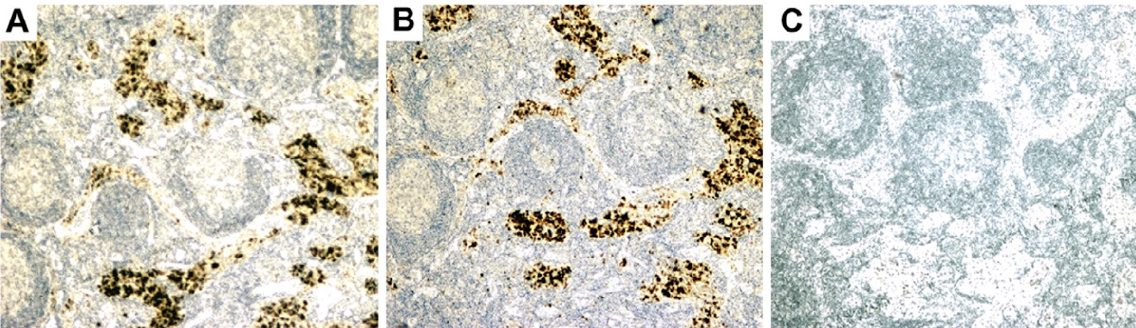
Figure 4. HBRV Capsid and Surface proteins in PBC perihepatic lymph nodes. These studies show immunostaining with ( A ) anti-MMTV p27 Capsid antibody and ( B ) anti-MMTV gp52 Surface anti- body in consecutive layers of PBC lymph node showing betaretrovirus proteins in the same distri- bution. In contrast ( C ), the control lymph node has no anti-MMTV p27 capsid antibody staining (H&E 200× magnification). Reproduced from Journal of Hepatology with permission, reference [71].